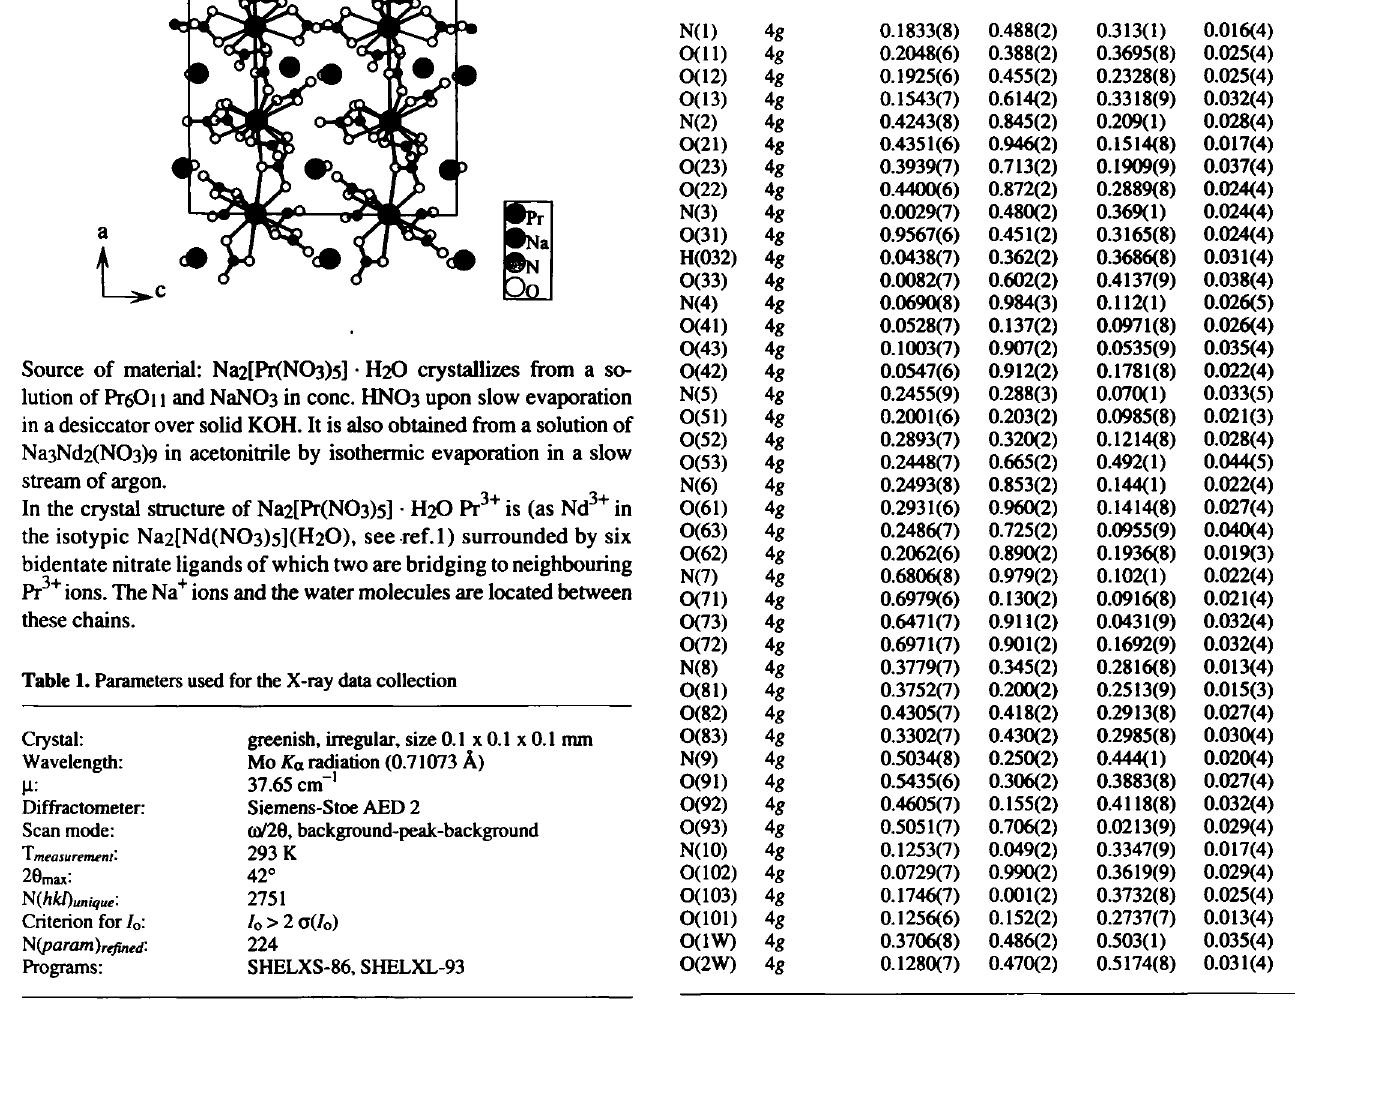
Table 2. Final atomic coordinates and displacement parameters (in Â 2